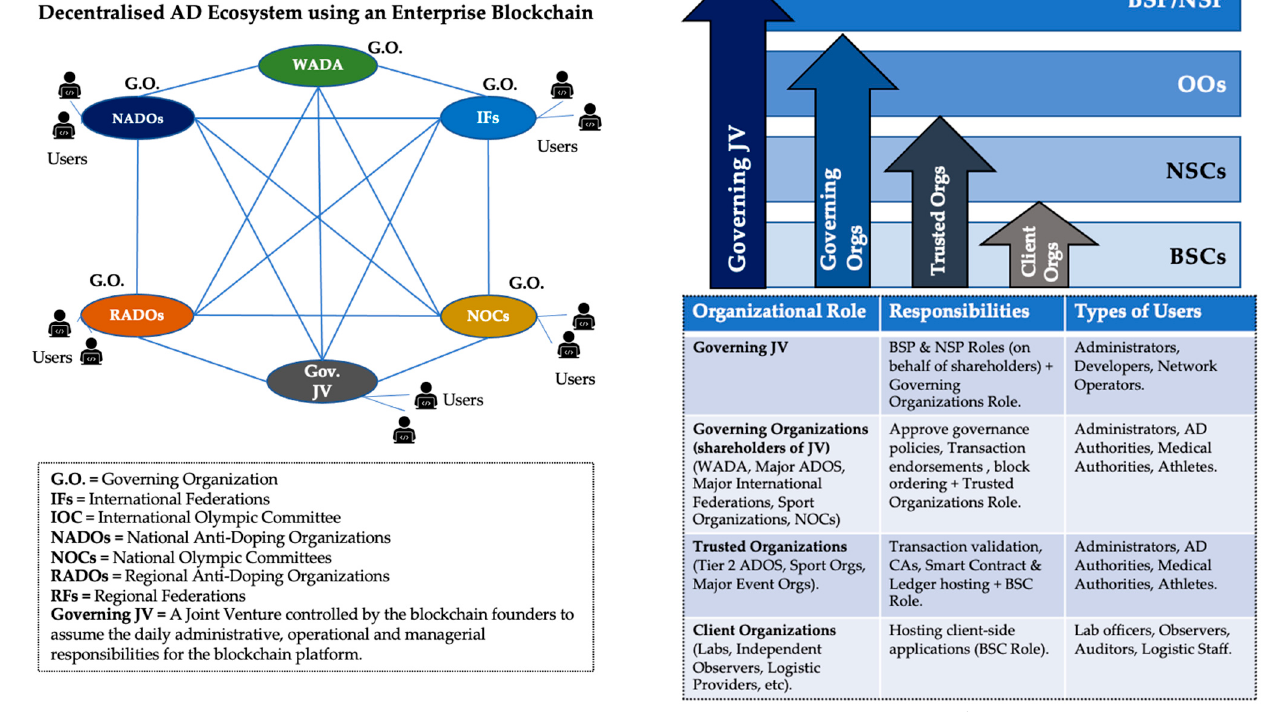
Figure 3. ( a ) A decentralized multiorganizational model for the AD ecosystem. ( b ) The governance hierarchy proposed for a decentralized AD ecosystem. Reference: [78].